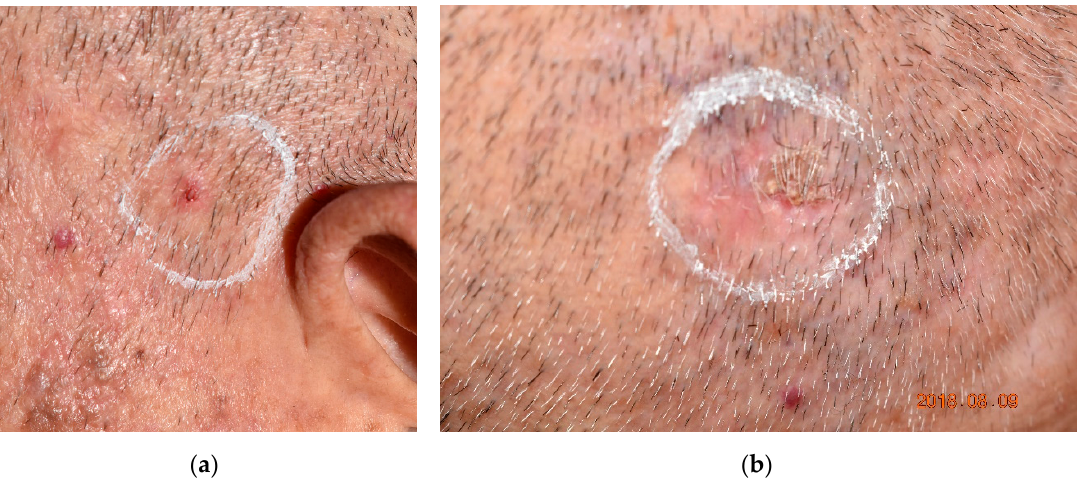
Figure 5. Clinical pictures of actinic keratosis (AK). ( a ) An erythematous AK locates on sun-damaged skin in an elderly patient. ( b ) A thick keratotic AK on the scalp of the same patient. In a thick AK, the hyperkeratotic skin surface prevents sufficient transdermal delivery of a photosensitizer for photodynamic therapy. The rough surface is usually removed by curettage before the application of a photosensitizer. AK lesions are highlighted by circles.